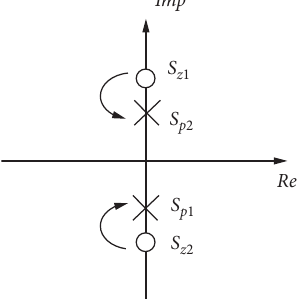
Figure 7: The free-vibration motion by the pole placement technique; o : zero, x :